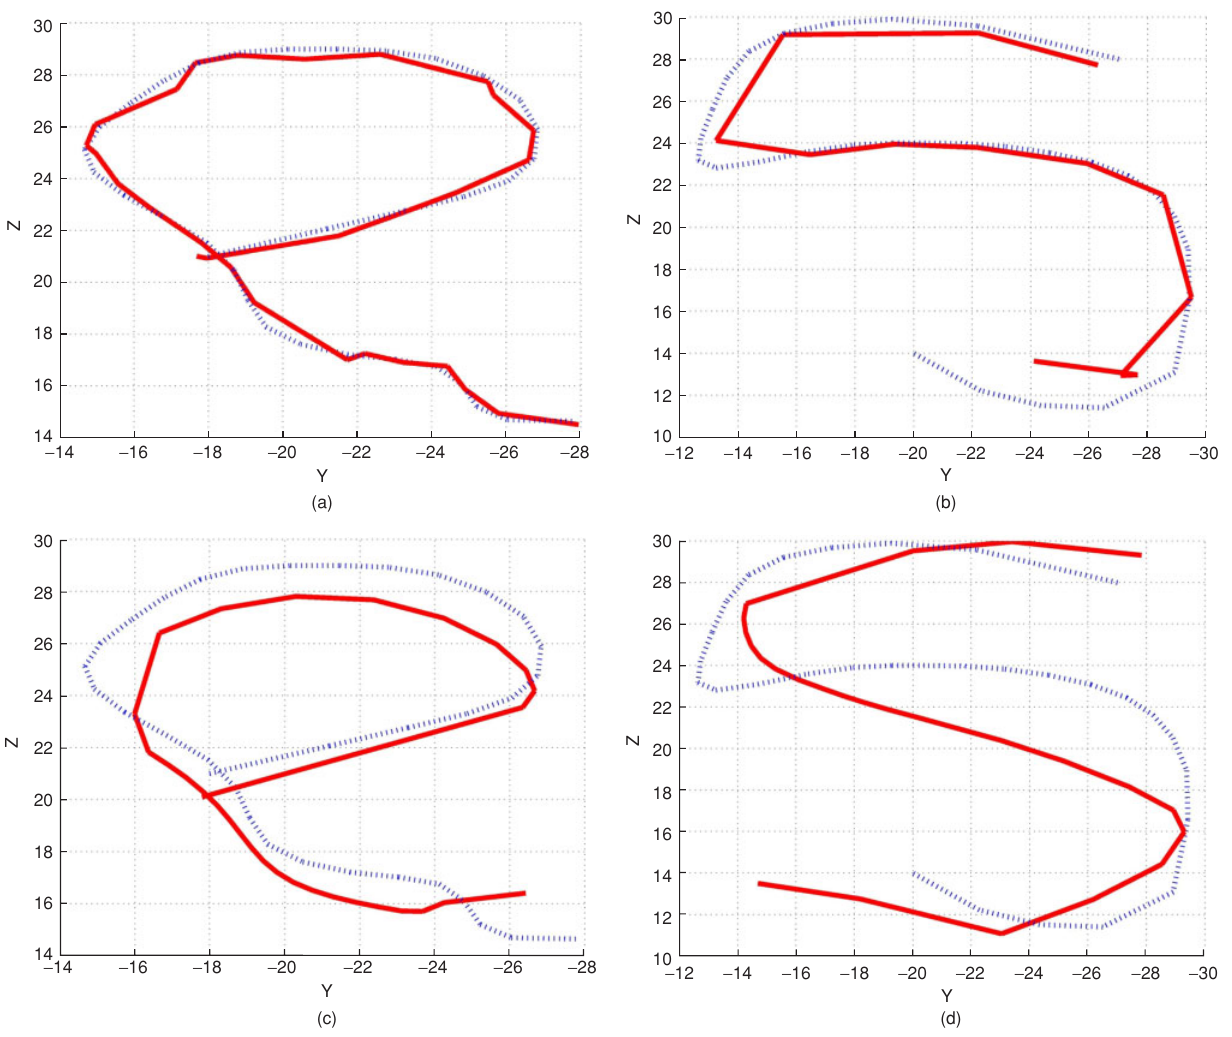
Figure 9 The performance of the robot in the solid line. In (a) and (c) the dotted line is the path of the demonstration from Figure 8a. While, (b) and (d) the dotted line is the path of the demonstration from Figure 8b. In (a) and (b) are the robot’s performance by a mimicry process of what the robot observed. In contrast, (c) and (d) are the robot’s performance by using the classifying